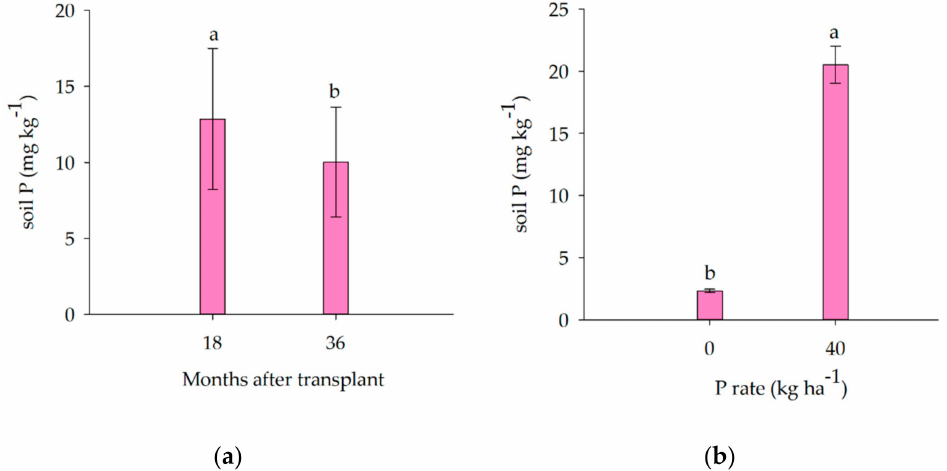
Figure 2. P concentration in the soil ( a , b ) of H. heptaphyllus plants (at 18 and 36 MAT) subjected to applications of 0 and 40 kg P ha − 1 . ( a ) depicts the adjusted bars with mean values at 18 and 36 months after transplant (MAT) compared based on Tukey’s test ( p < 0.05) without considering the P rate, since the interaction was not significant at 5% based on two-way analysis of variance. ( b ) depicts the adjusted bars with mean values of the P rate compared based on Tukey’s test ( p < 0.05) without considering time, since the interaction was not significant at 5% based on two-way analysis of variance. Vertical bars represent the standard error of three